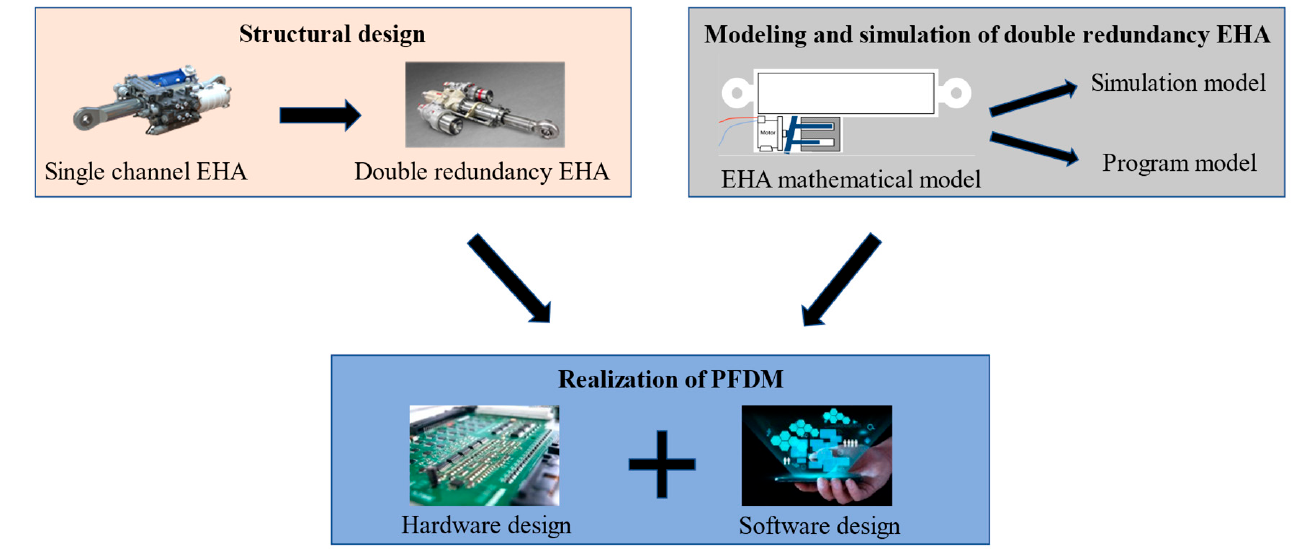
Figure 1. Design method of PFDM.